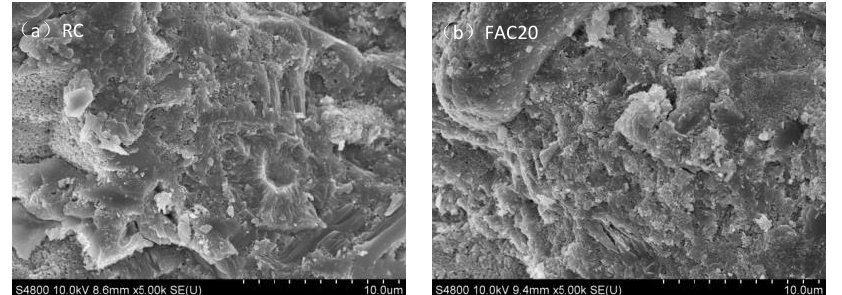
Figure 7. Micro-structure of Portland cement and composite cement pastes at 28d age: ( a ) RC; ( b ) FAC20.